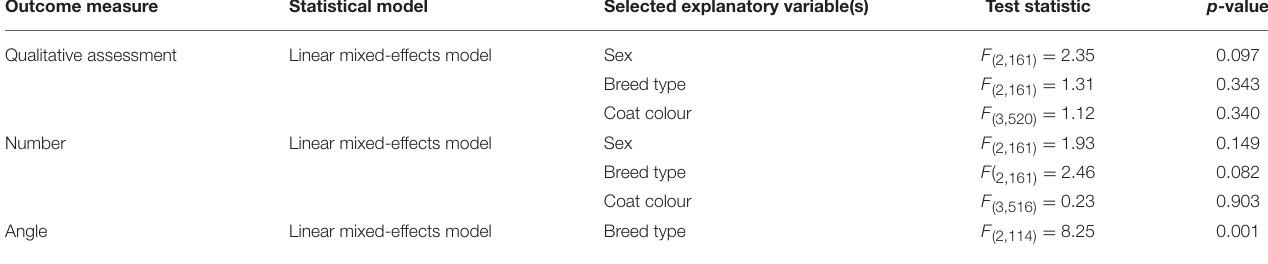
TABLE 3 | Statistical models, explanatory variables to be included in the final model and results for the three outcome measures.